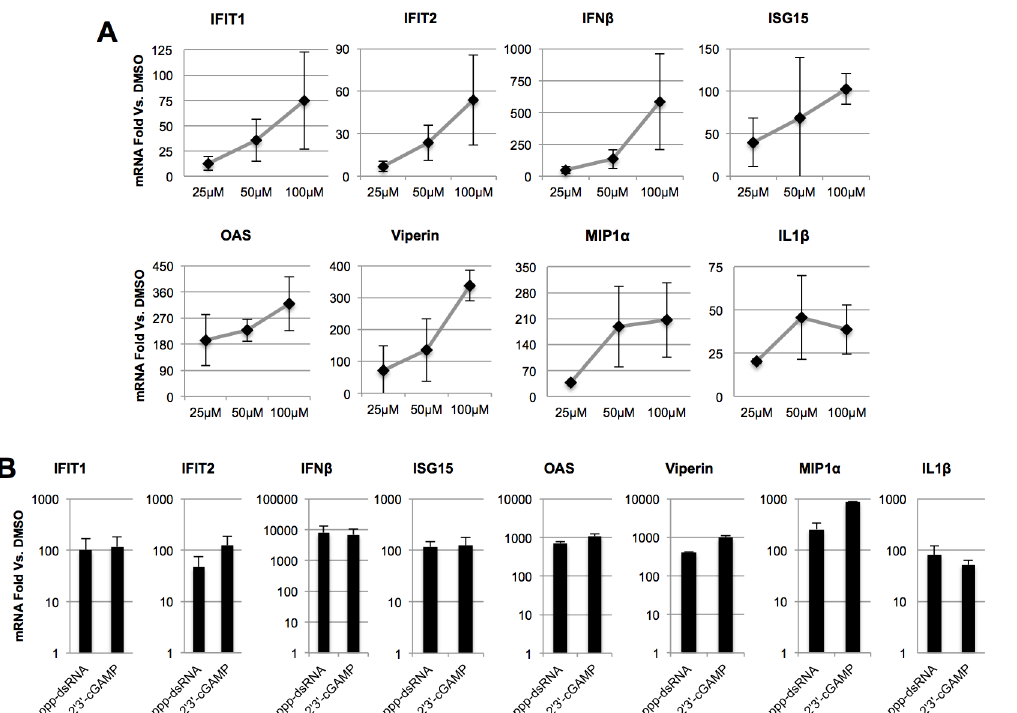
Fig 10. G10-mediated Induction of mRNA in PBMCs. mRNA synthesis of indicated genes in human peripheral blood mononuclear cells (PBMC) following 8h exposure to indicated concentration of G10 (A) or ppp-dsRNA (12.5 μ g/mL) or 2 ’ 3 ’ -cGAMP (28 μ M) (B). Indicated values represent average mRNA fold change ± SD from duplicate experiments relative to cells exposed to 1% DMSO.